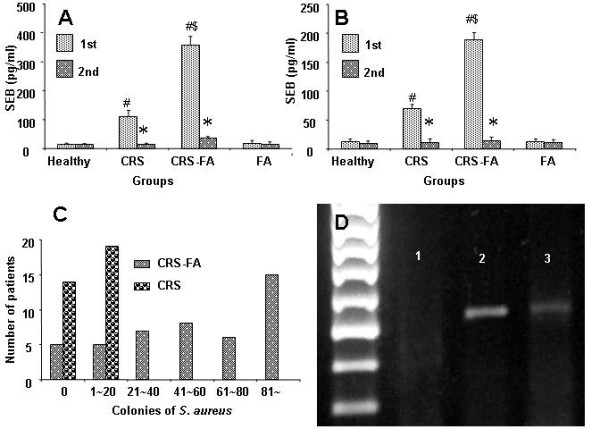
SEB was detected in the sinuses and in the stools of CRS-FA patients. Bars represent SEB levels in the sinus (or nasal) wash fluids (A) or in the stools (B) that were detected with ELISA. Data are expressed as mean ± SD. *, p < 0.05, compared with values of the 1st tests (before the sinus surgery; 2nd: 2 months after the sinus surgery). #, p < 0.05, compared with healthy controls. $, p < 0.05, compared with CRS patients. C, S. aureus was identified with the surgical sinus samples after bacterial culture. D, S. aureus DNA was identified with PCR. Band 1 is the negative control; bands 2 and 3 are the representative bands of samples from patients with CRS-FA.